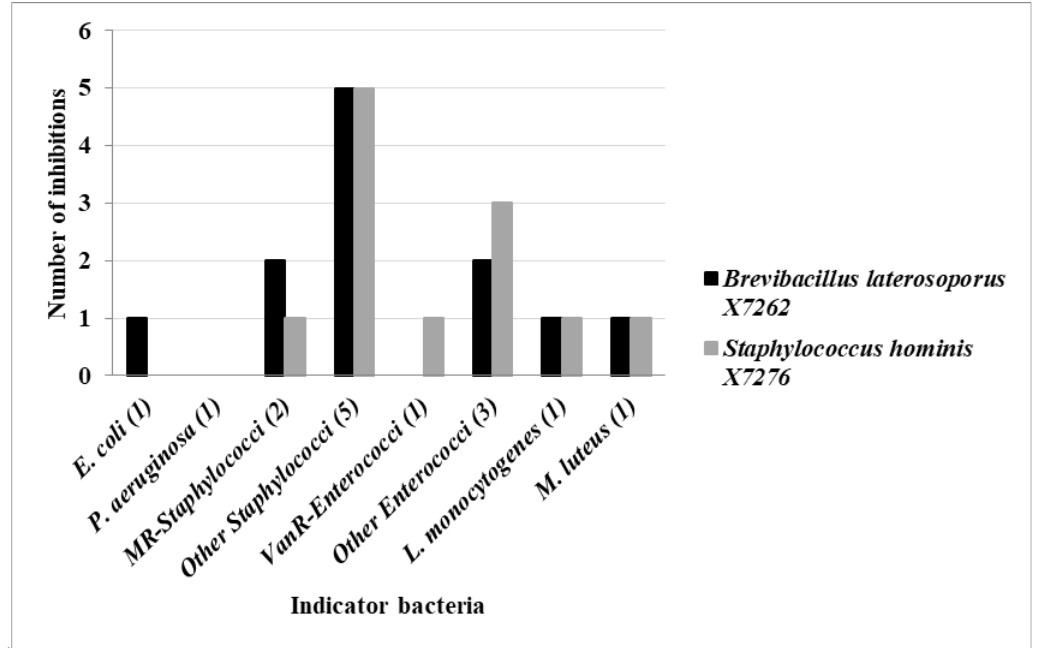
Figure 2. Number of indicator bacteria inhibited by the two highly producing isolates ( Brevibacillus laterosporus X7262 and Staphylococcus hominis X7276). 3.2. Antibiotic Resistance Phenotype of the Antimicrobial-Producing Isolates In total, 48% of the 32 antimicrobial-producing isolates showed susceptibility to all the antibiotics tested. Considering Gram-positive isolates, resistance was mostly detected for cefoxitin (22%) and penicillin and tobramycin (17%). Meropenem/imipenem and ciprofloxacin resistance were also found among Bacillus isolates. Four Gram-positive pro- ducing isolates (17%) were multidrug resistant (MDR). With respect to Gram-negative, 33% of them were susceptible to all the antibiotics tested (all belonging to Pseudomonas genus). Four Pseudomonas spp. showed resistance to ticarcillin, and two of them were also resistant to aztreonam. Moreover, two Gram-negative isolates were resistant to ampicillin and cefoxitin, one of them being MDR ( Olivibacter X7265) (Table 4). Table 4. Antimicrobial resistance phenotype of the selected 32 antimicrobial-producing isolates ob- tained in the second screening. Type of Bacteria